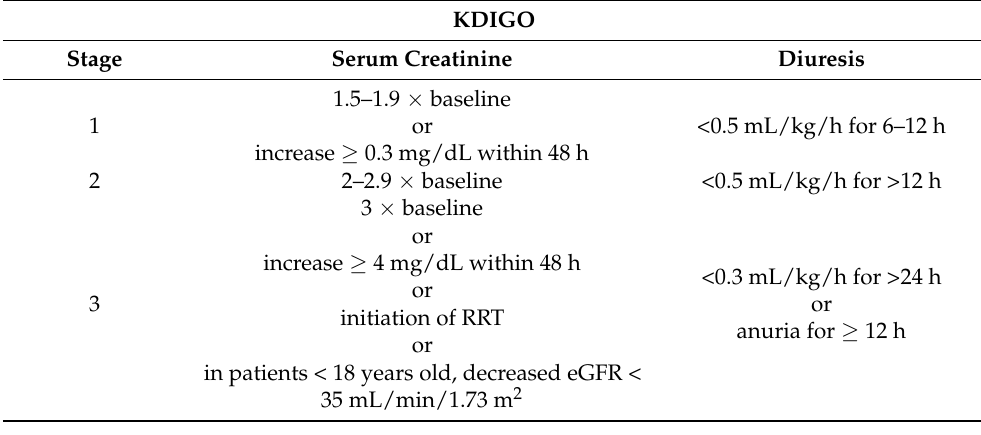
Table 2. KDIGO criteria for AKI.